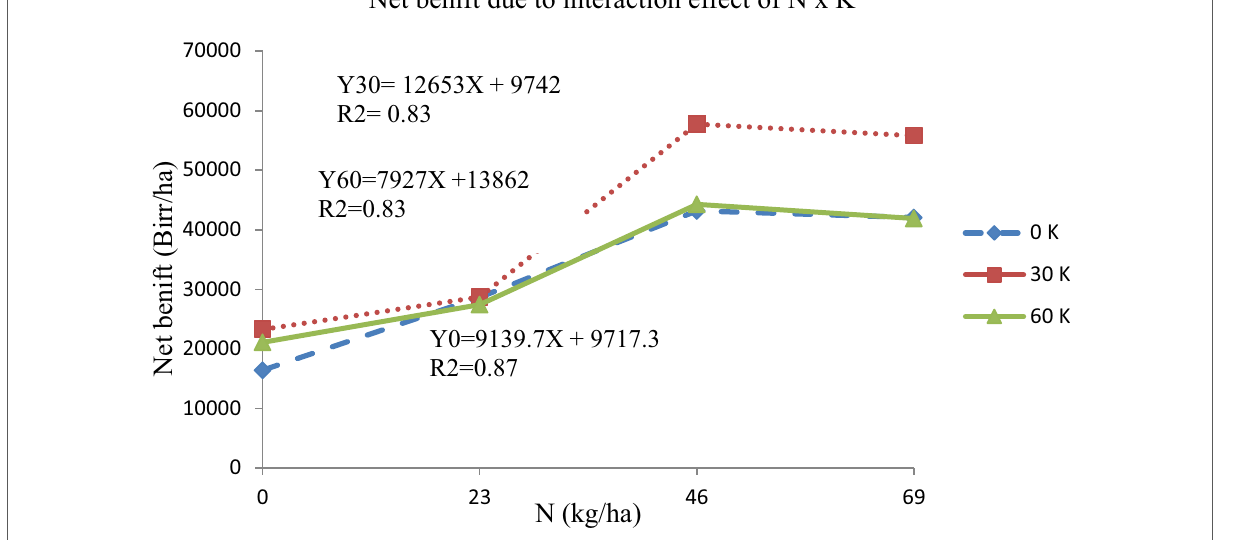
Fig. 6 Regression analyses of interaction effects of N and K on net